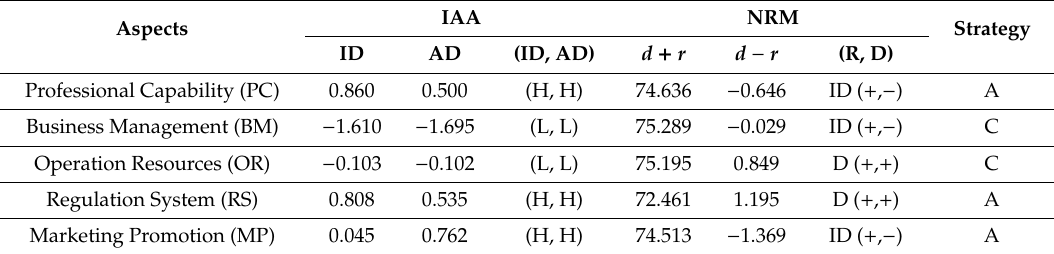
Table 11. The development strategy for urban sustainable development.